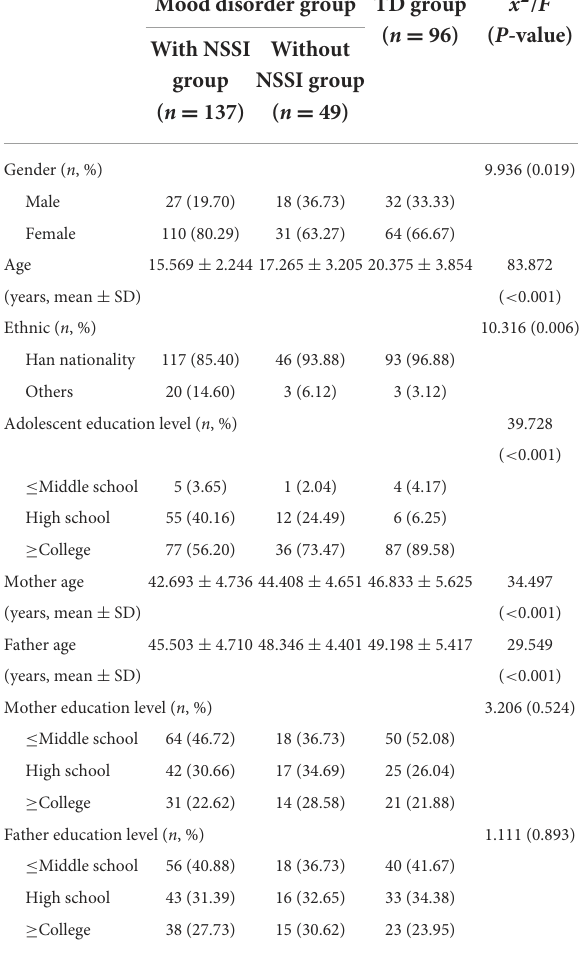
TABLE 1 Sociodemographic characteristics of